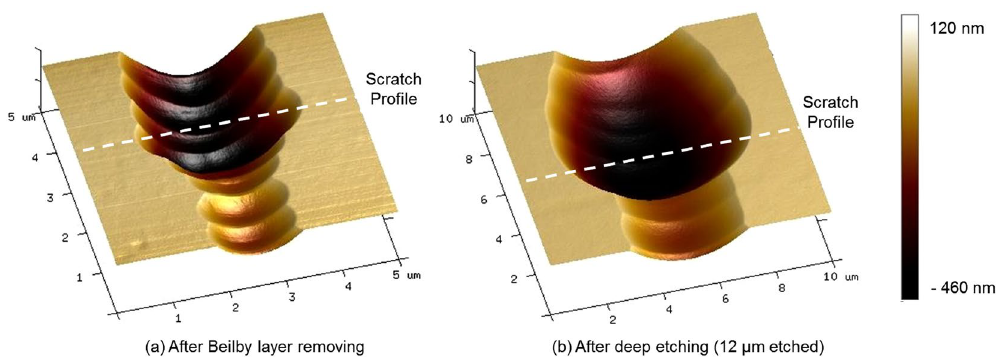
Figure 2. AFM observations of a brittle scratch ( a ) before and ( b ) after 12 µ m deep acid etching. Dotted lines correspond to the profiles presented in Fig. 3.